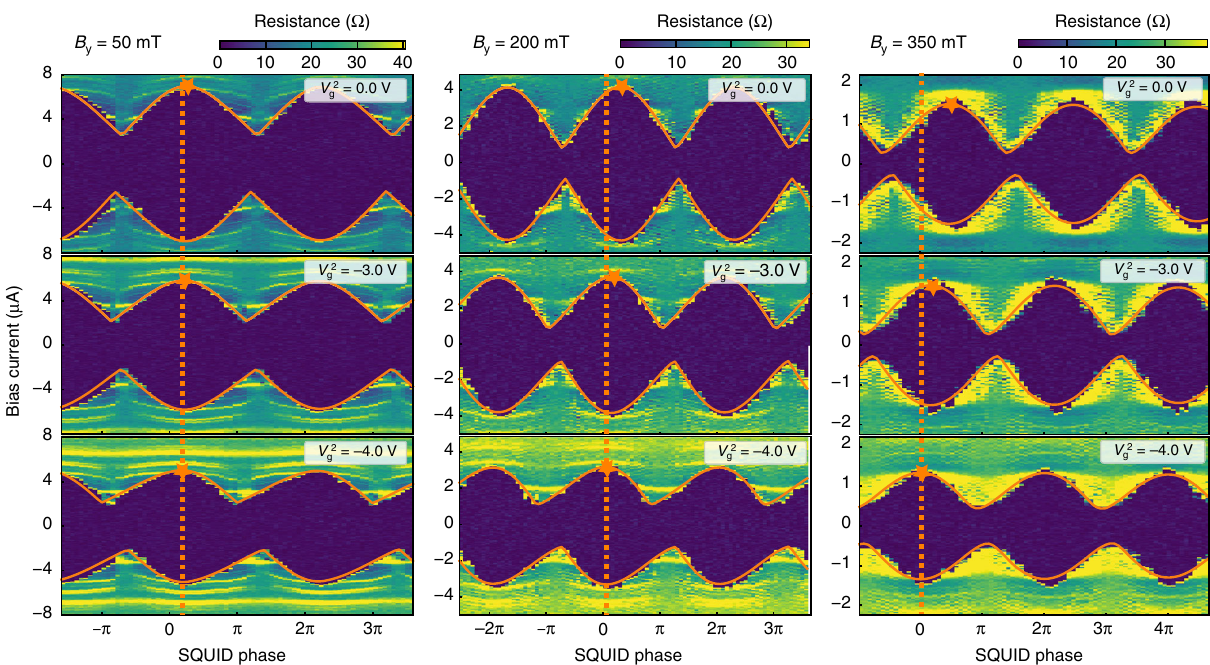
Fig. 3 Resistance of the device as a function of the phase bias applied on the SQUID and the bias current at three different values of the in-plane fi eld B 2 is set to − 2 V. The dashed orange line indicates the position of the maximum of the oscillation at . In all scans V 1 y and three different values of V g g ¼ (cid:2) 4 V . Orange stars indicate the position of the maximum at each fi eld. V 2 g